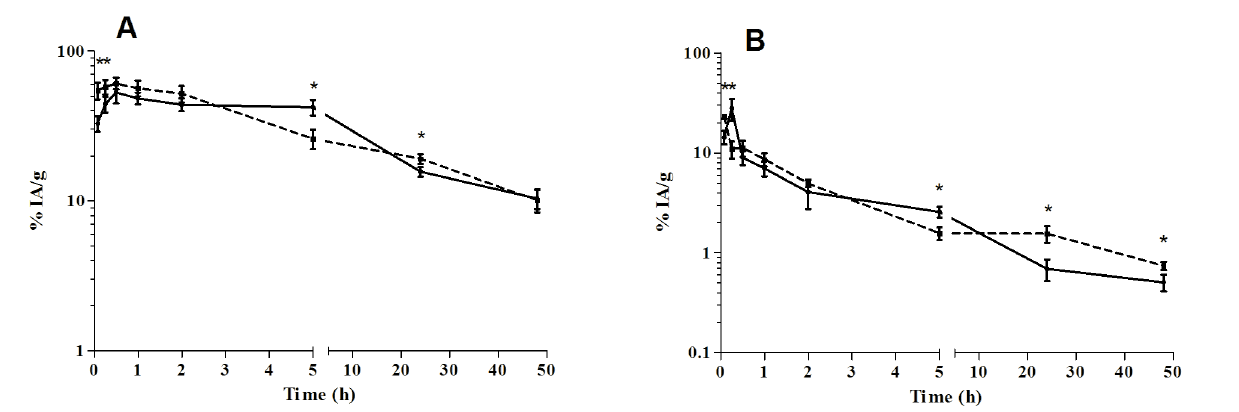
respective levels at 48 h of 0.51% IA/g and 0.74% IA/g (p = 0.0073) in infected and uninfected mice (Fig.